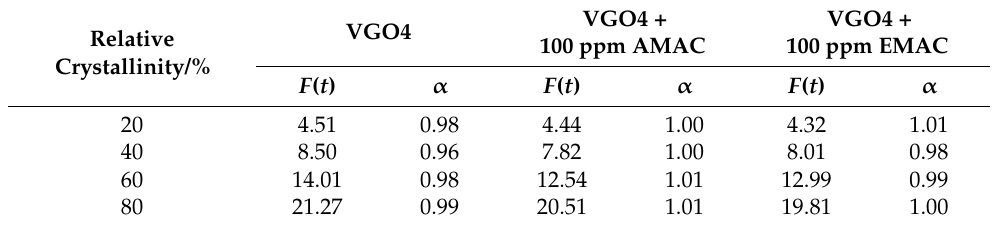
Table 11. Values of the intercept ( F ( t )) and slope ( α ) are obtained from Figure 9.